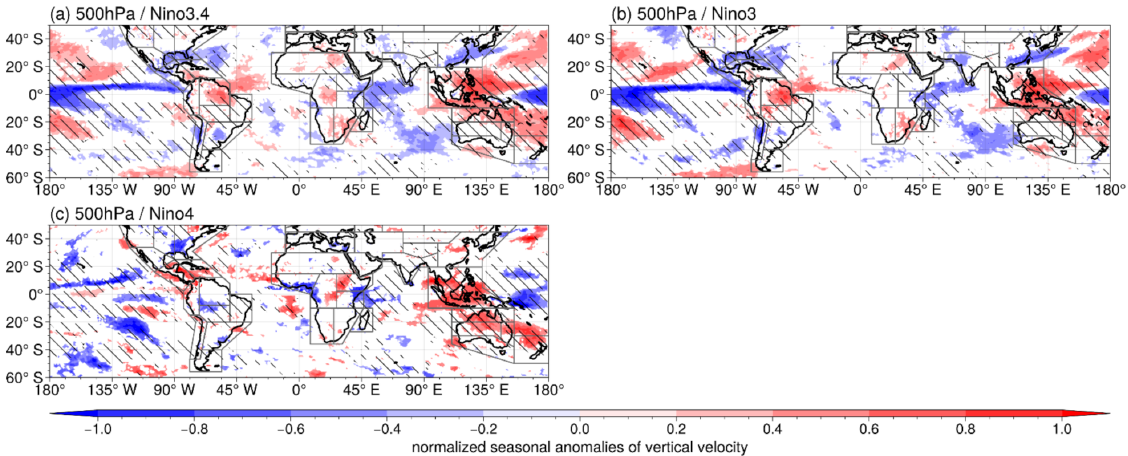
Figure 13. Normalized seasonal anomalies of vertical velocity and the information flow from Nino3.4, Nino3, and Nino4 to SPI3 from 1951–2020. The contours and slashed areas are all significant at a 95% confidence